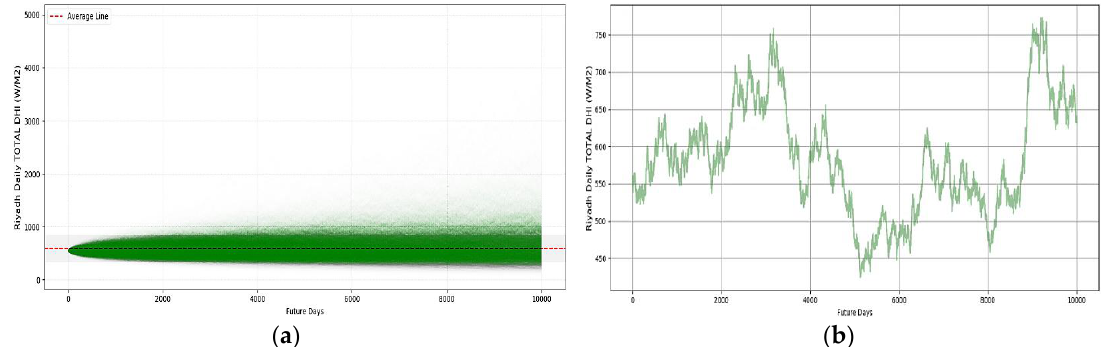
Figure 12. ( a ) Daily total solar DNI distributions for the south region, as predicted by MCS and BM, and ( b ) a one-day scenario for the solar DNI distribution prediction performance.